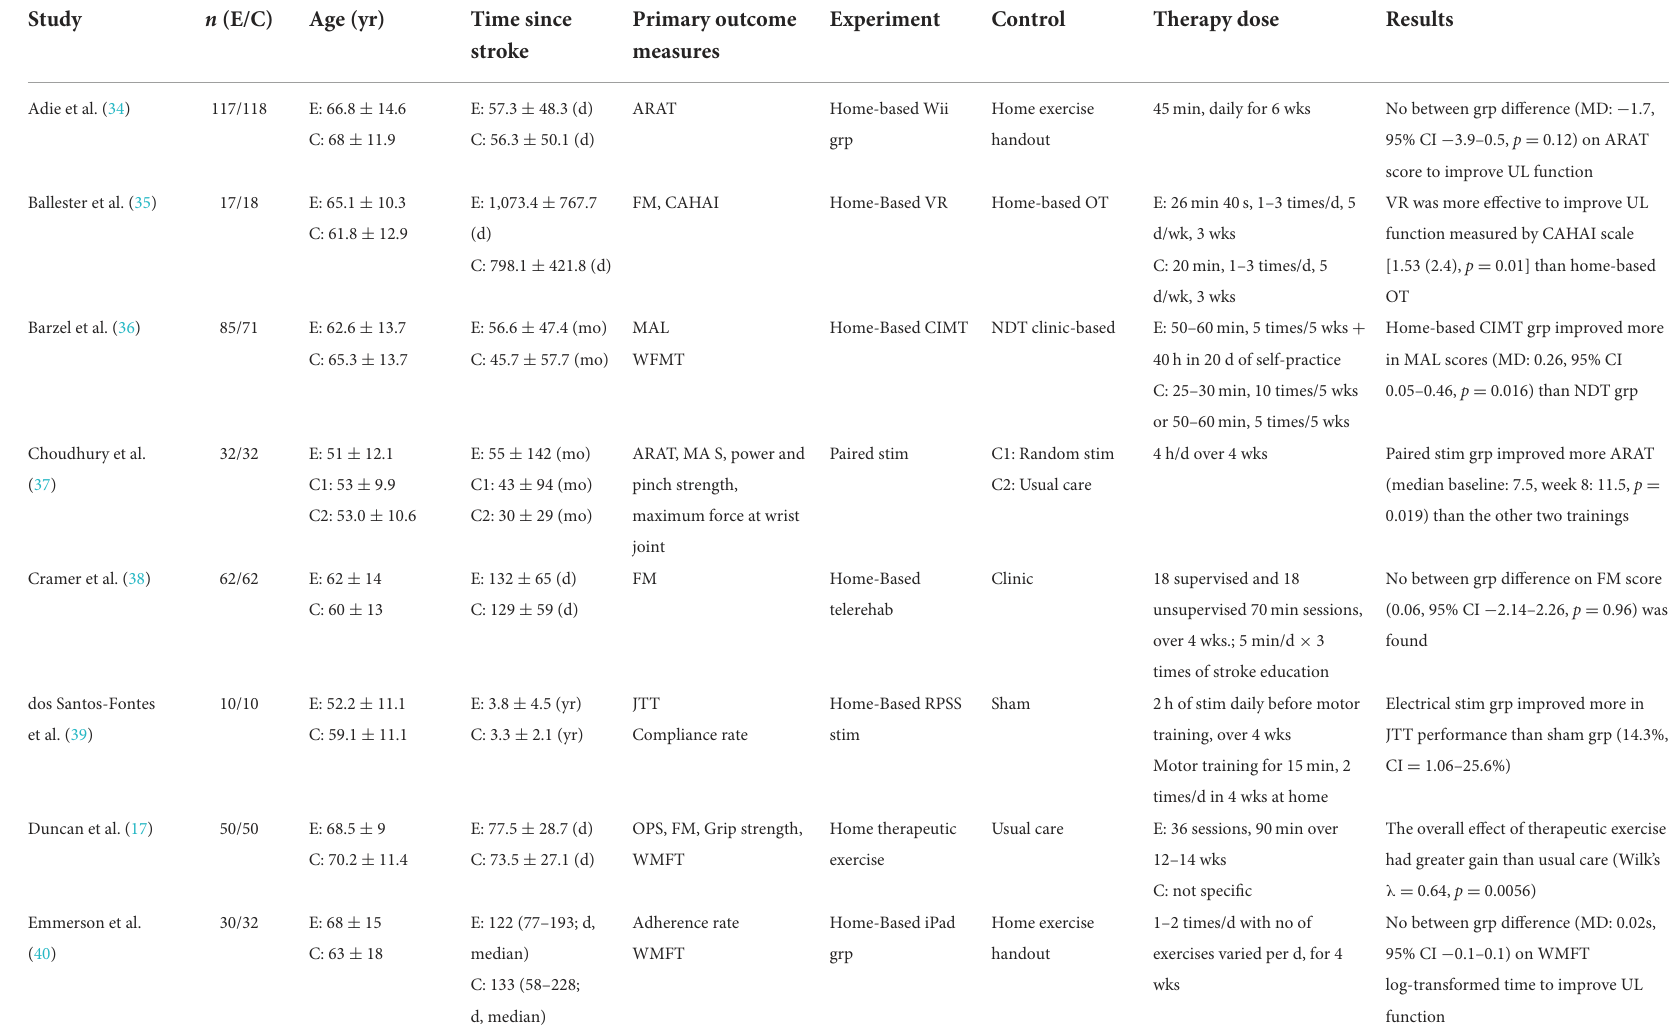
TABLE 1 Characteristics of included